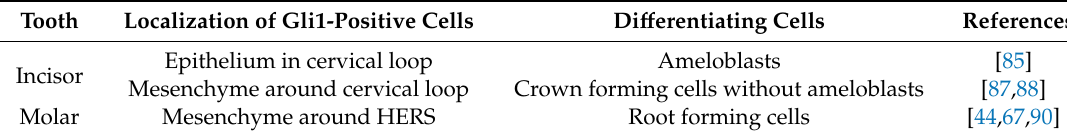
Table 2. Di ff erentiatial ability of Gli1-positive cells in mouse developing tooth. Tooth Localization of Gli1-Positive Cells Di ff erentiating